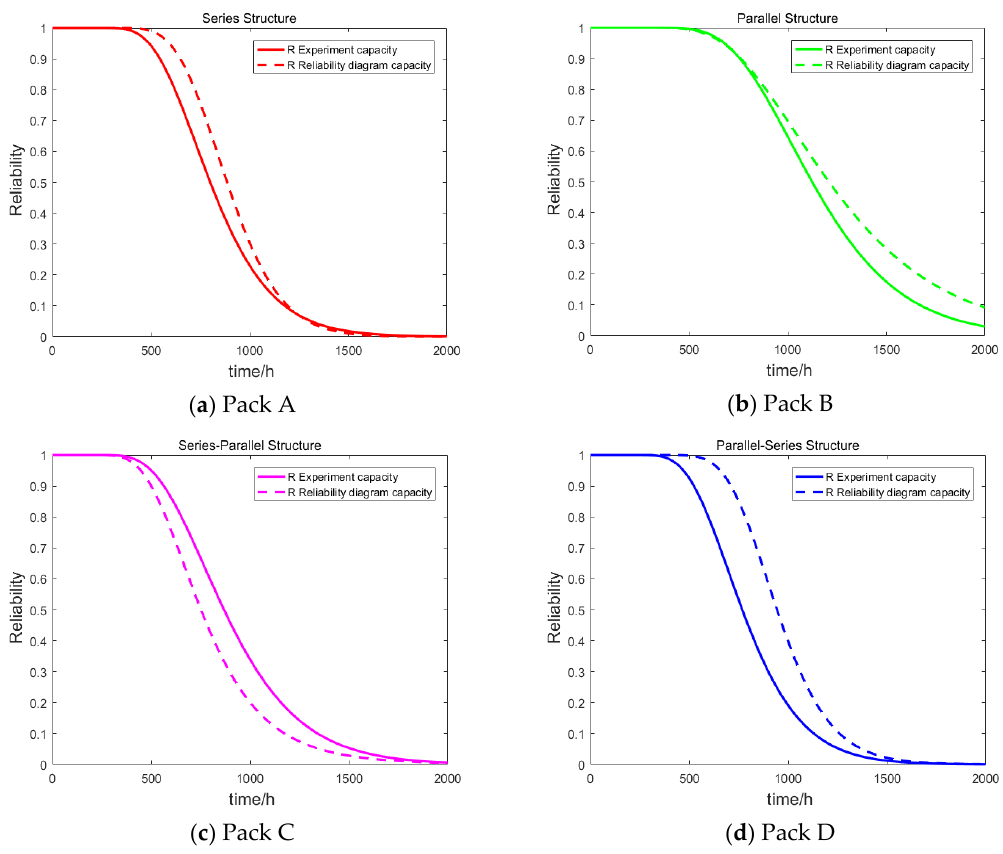
Figure 3. Comparison of reliability of the RBD model with the real reliability of the four battery packs: